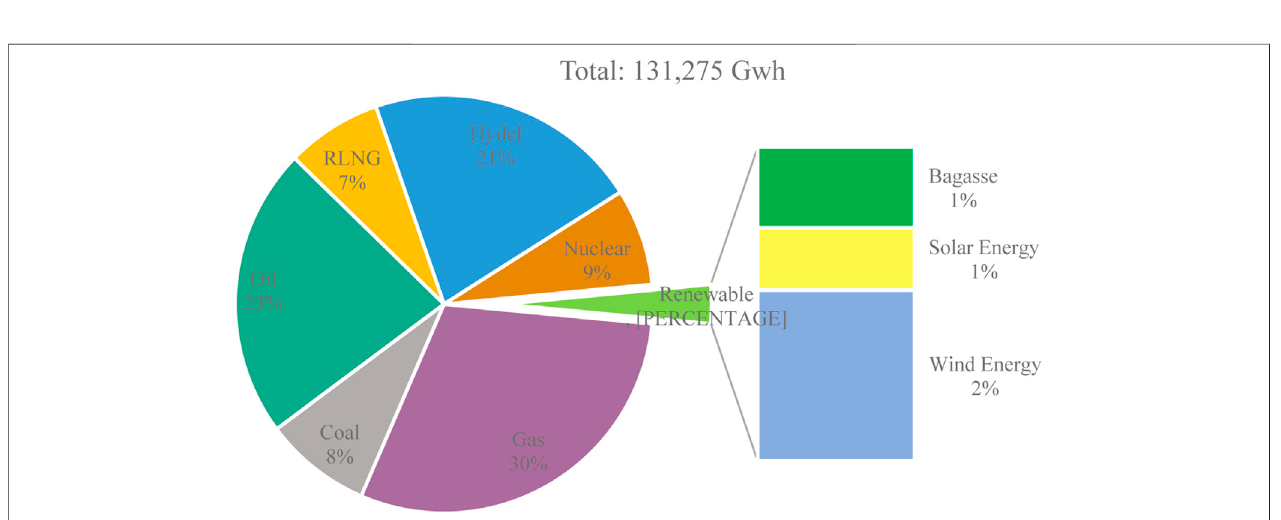
FIGURE 2 | Electrical energy generation mix of Pakistan 2017 – 18 (HDIP Ministry of Energy Government of Pakistan, 2019).